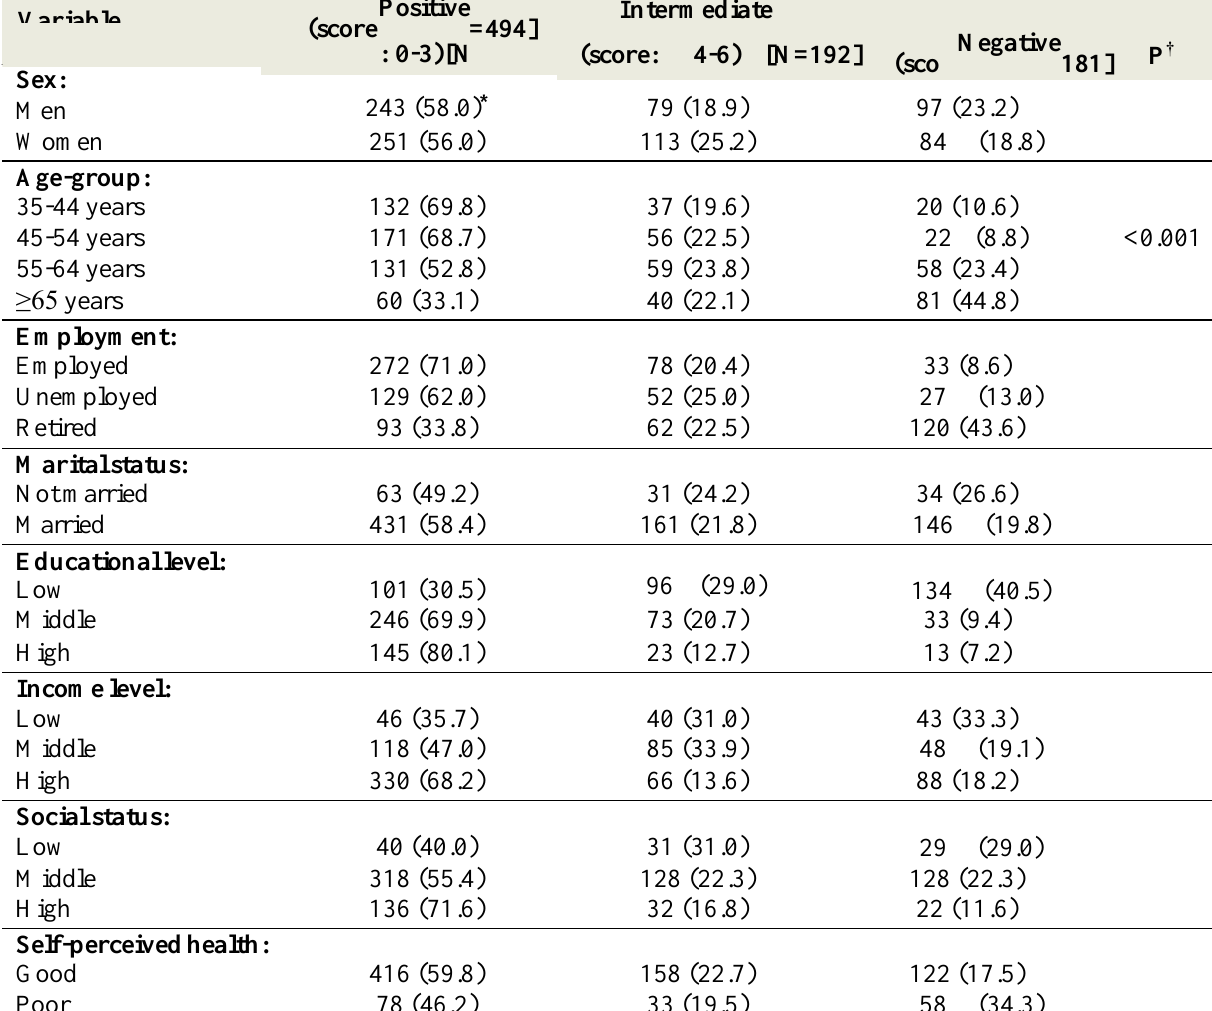
Table 2. Distribution of socio-demographic characteristics and self-perceived health statusby reaction to transition scores in the study population(N=867) Positive Variable